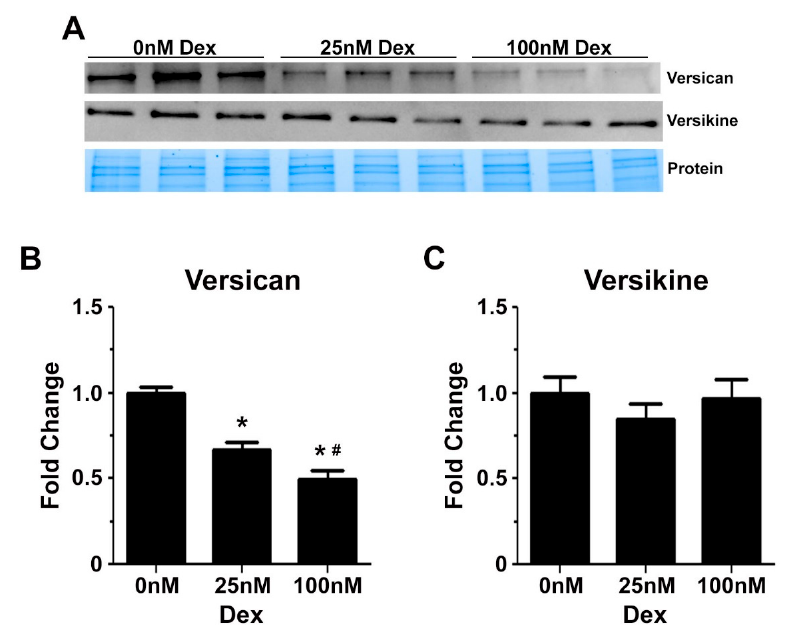
Figure 6. Versican and versikine protein expression in differentiating C2C12 myoblasts following dexamethasone treatment. ( A ) Representative western blots to assess versican and versikine expression in C2C12 cell lysates, with the respective stain free protein gel image to demonstrate even protein loading. ( B ) Decreased versican protein expression following treatment with 25 nM (* p = 0.00002) and 100 nM dexamethasone (* p = 0.0000001); and this decrease was dose dependent ( # p = 0.03). ( C ) Versikine protein levels were not altered by dexamethasone treatment. Versican and versikine protein expression analysis was calculated from n = 3 biological replicates performed in quadruplicate. Error bars = S.E.